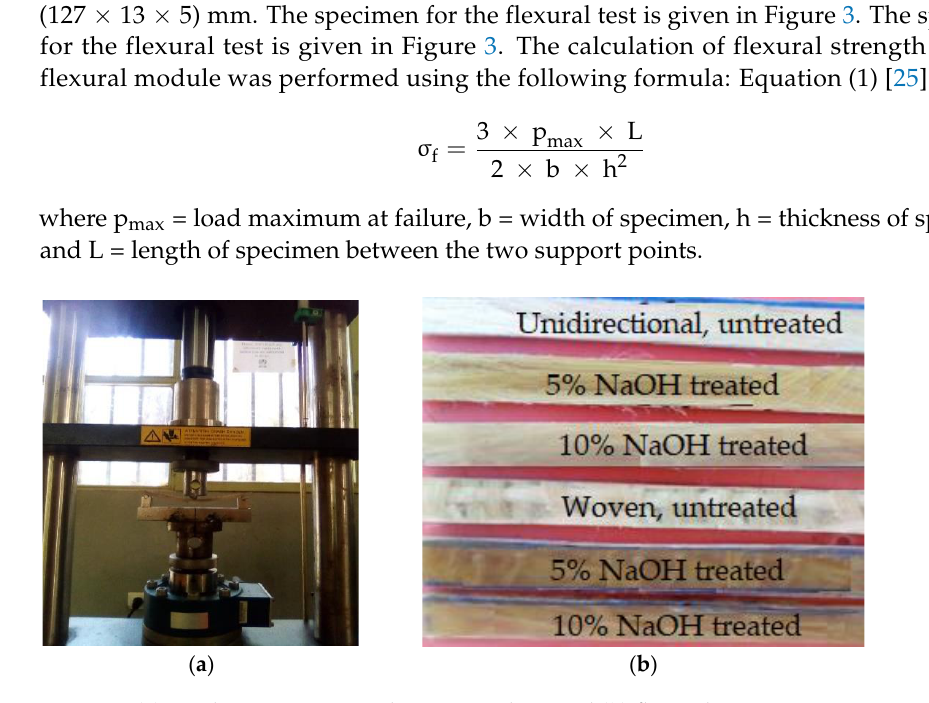
Figure 3. ( a ) Bending test setup in the UTS machine and ( b ) flexural test